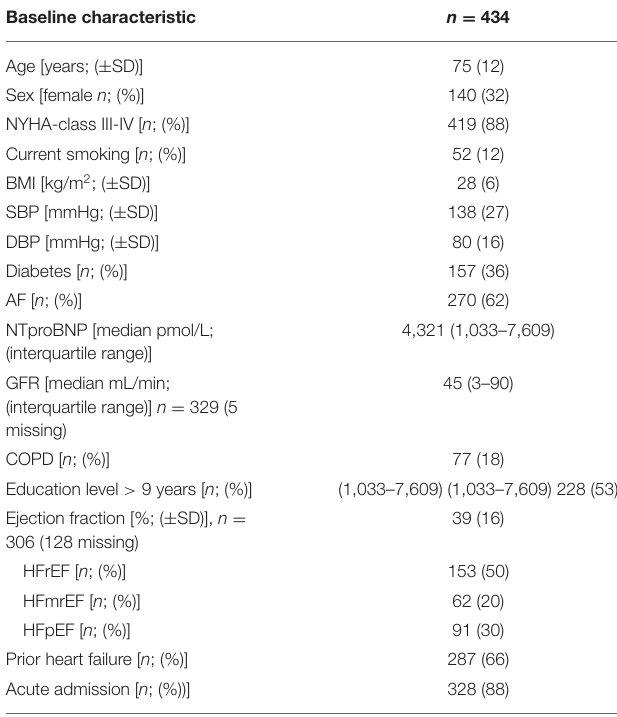
TABLE 1 | Characteristics of study participants ( n = 434) at baseline.